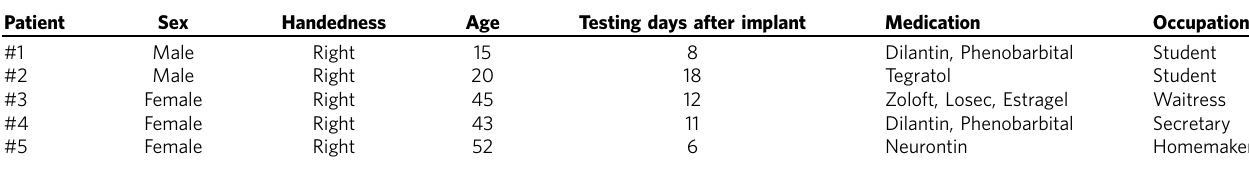
Table 1 | Patient